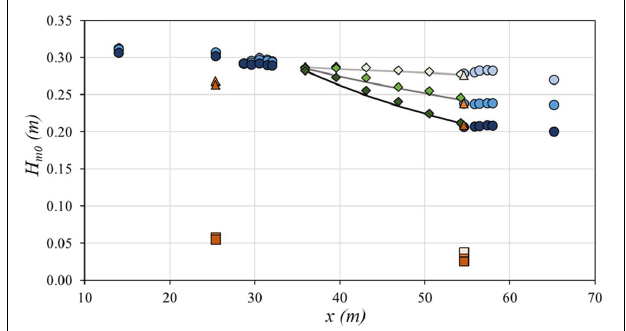
FIGURE 7 | Total spectral estimate of the significant wave height with respect to x -location for WGs (blue circles) and PD18s (green diamonds) and the incident spectral estimate of the significant wave height (orange triangles), and reflected spectral estimate of the significant wave height (orange squares) for the high-density (dark colors), low-density (intermediate colors), and baseline (light colors) configurations for random wave case TI-h3-3, h v = 1.03 m, H m 0 = 0.310 m, T p = 3.10 s.